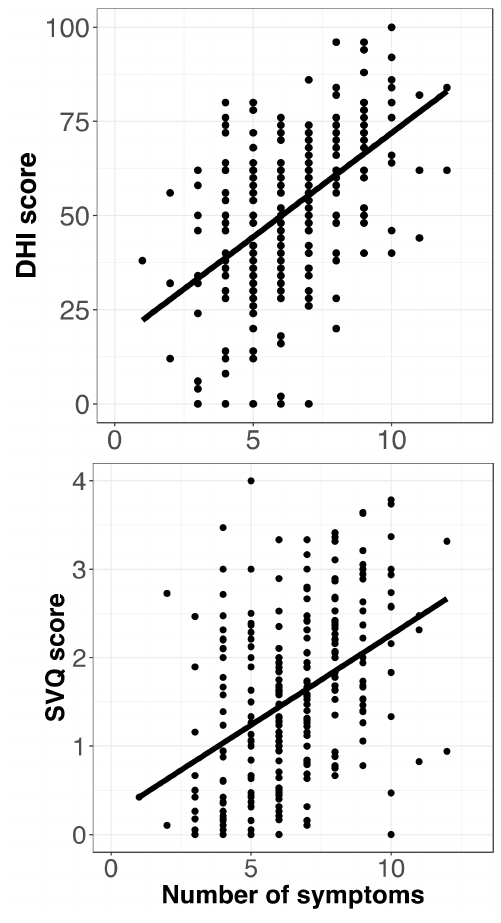
Figure 3. Scatter plots of the Dizziness Handicap Inventory (DHI) overall scores ( top ) and the Situational Vertigo Questionnaire (SVQ) scores ( bottom ) against the number of symptoms reported by FM participants. Regression lines are also